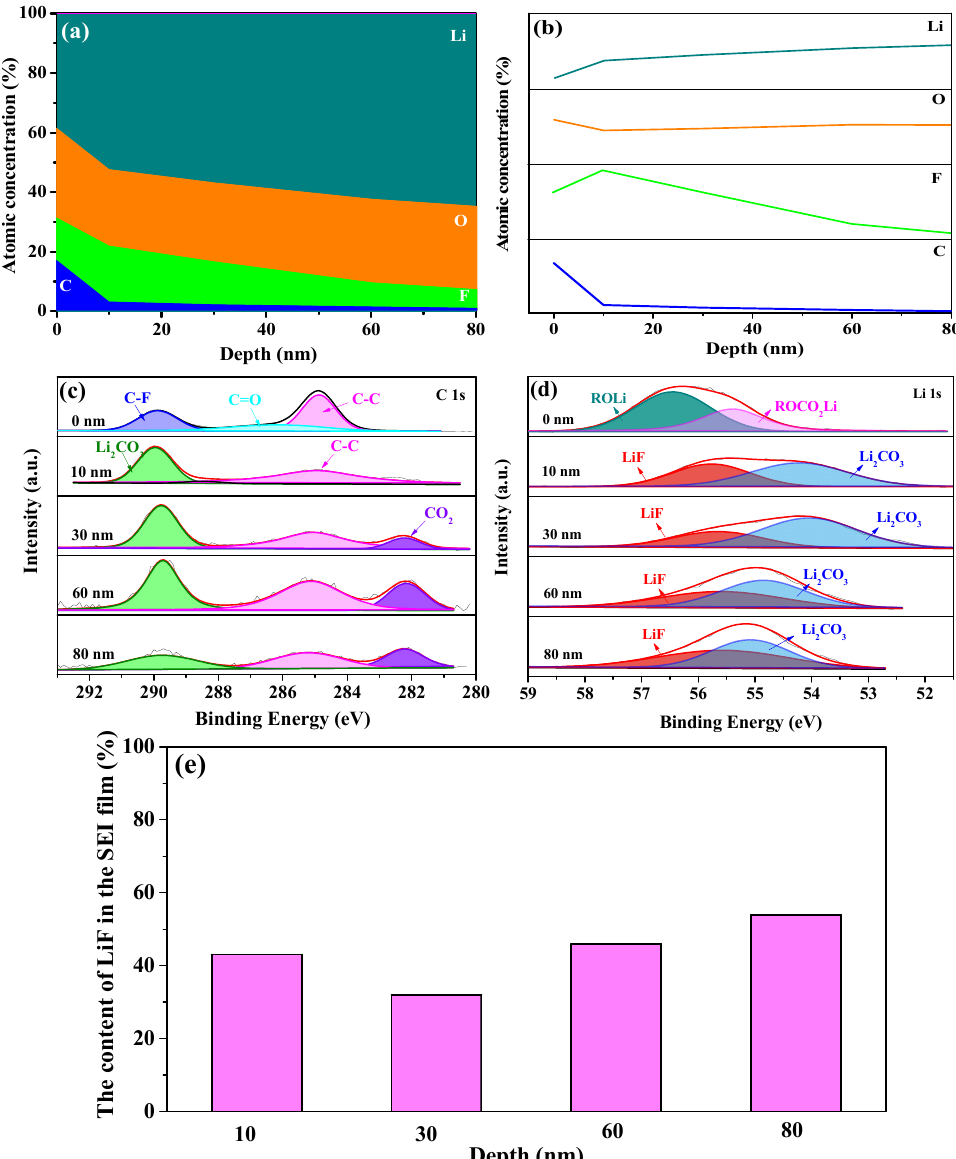
Figure 8. The surface chemistry of the 5% FEC-RT-7D battery investigated by XPS. The evolution profiles of the ( a ) atomic percentages and ( b ) relative elemental intensities along the depth direction are shown. XPS spectra of ( c ) C 1s and ( d ) Li 1s along the depth direction. ( e ) The distribution of LiF along the depth